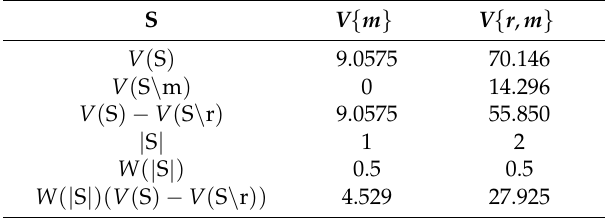
Table 5. Income distribution for the resource processor under a cooperative centralized